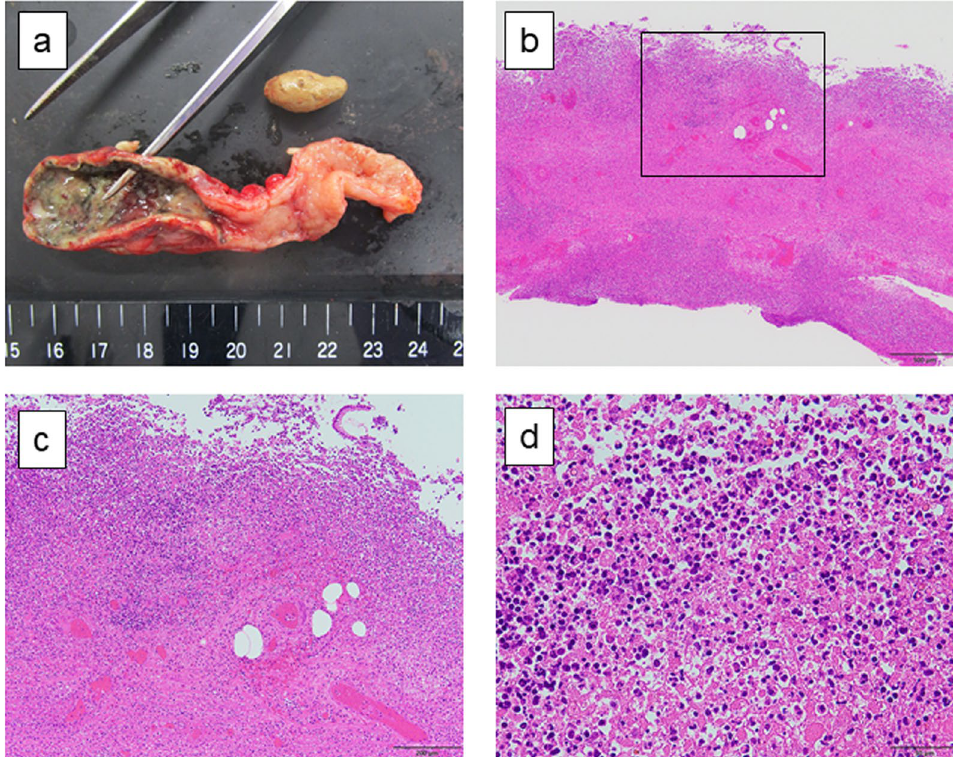
Fig. 3 Histopathological findings of the extracted appendix. The pathological findings were consistent with phlegmonous appendicitis. The gross appearance revealed whole layer necrosis at the apical side of appendix, whereas the inflammation at the basal side of the appendix was limited. Fecaliths were found inside the appendix ( a ). b – d The markedly inflamed appendix with mucosal ulceration and transmural neutrophilic inflammation extending through the muscularis propria to the serosal surface. c Shows a high power field of the box in b . The scale bar indicates 500 µm in b ; 200 µm in c ; 50 µm in d . The magnification is 40 in b ; 100 in c ; 400 in × × ×